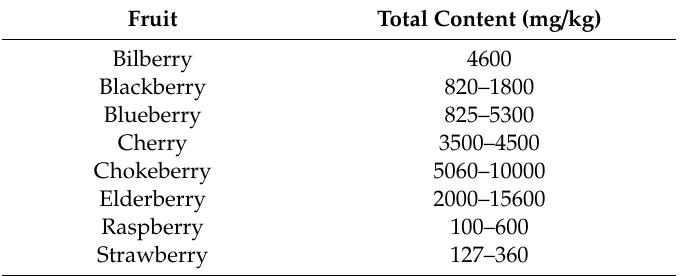
Table 1. Range of total anthocyanin content in commonly consumed fruits 1